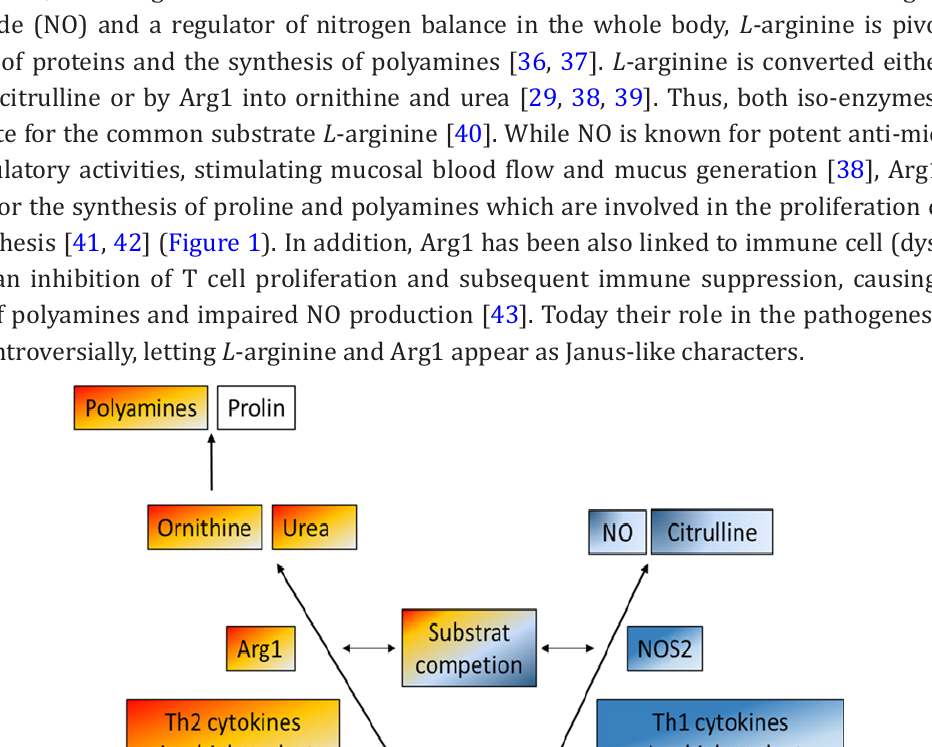
On the one hand, Arg1 expression correlates with the degree of inflammation observed in tissue biopsies L of patients suffering from IBD and in animal colitis models [29, 44-47]. Subsequently, the intraluminal L Arg1 availability of -arginine is reduced in IBD patients [48]. Accordingly, improved intraluminal availability of -arginine and genetic deletion of in hematopoietic and endothelial cells mediated significant protection from experimental colitis